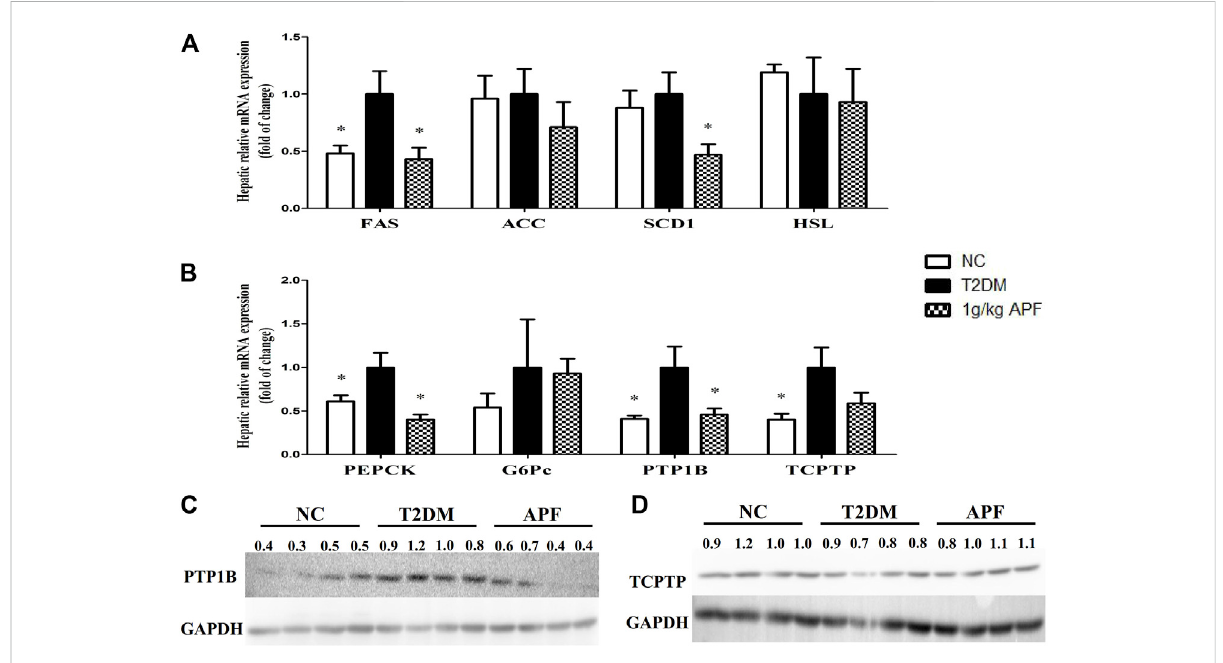
FIGURE 8 Effects of APF on liver in T2DM mice. Hepatic FAS, ACC, SCD1, HSL (A) , PEPCK, G6Pc, PTP1B, TCPTP (B) relative mRNA expression and protein expression of P1P1B (C) and TCPTP (D) of normal control (white bars), type 2 diabetes group (black bars) and 1 g/kg APF group (grid bars) after treatment with APF 12 weeks. Values are means ± SEMs, n = 4 – 5 per group. * p < 0.05, ** p < 0.01 versus type 2 diabetes